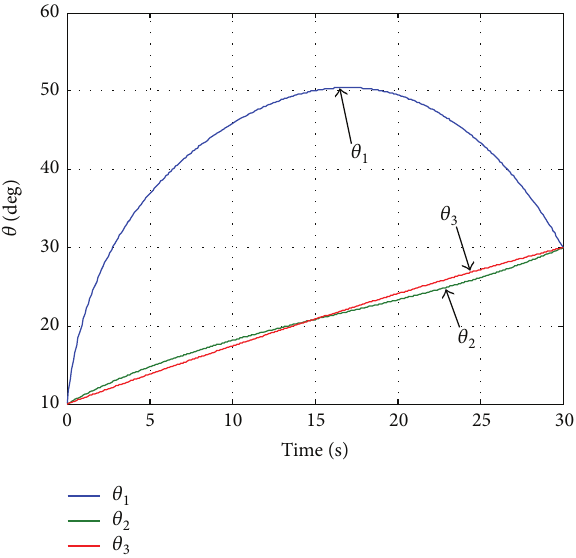
Figure 8: Illustration of the indicators of evaluation.